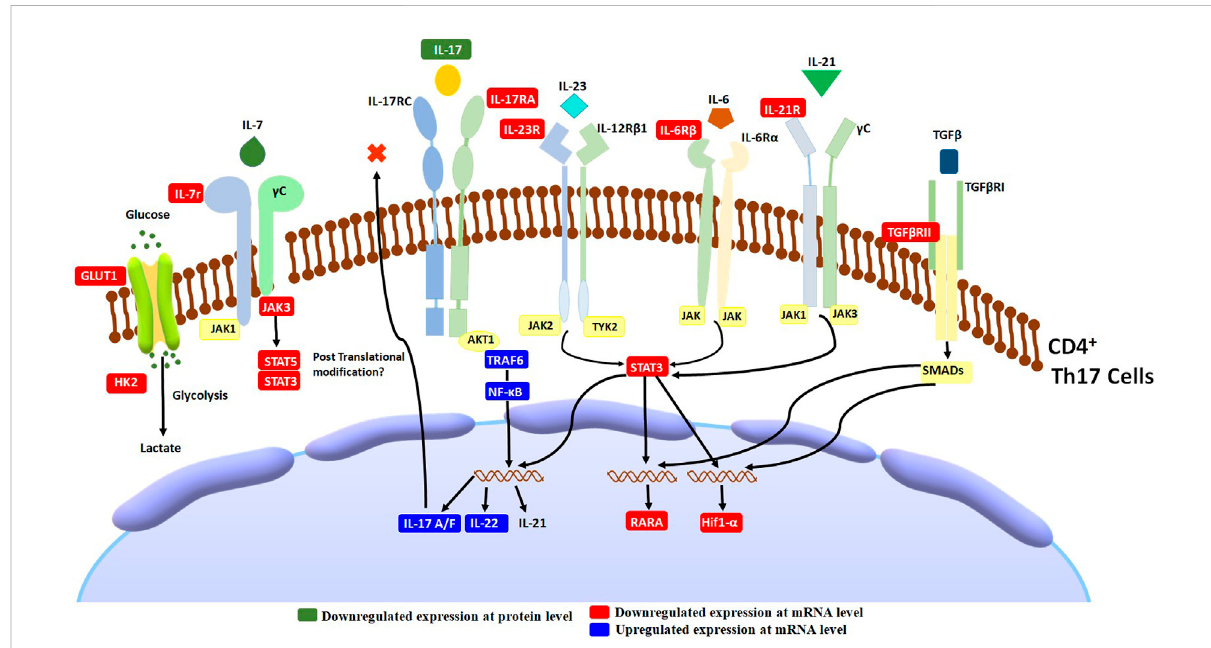
FIGURE 6 Schematic diagram of T. cordifolia therapeutic effects on Th17-associated in fl ammation. AETC treatment exerts its effect by reducing the expression of genes involved in Th17 cell differentiation, cytokine-receptor signaling, and the JAK-STAT signaling